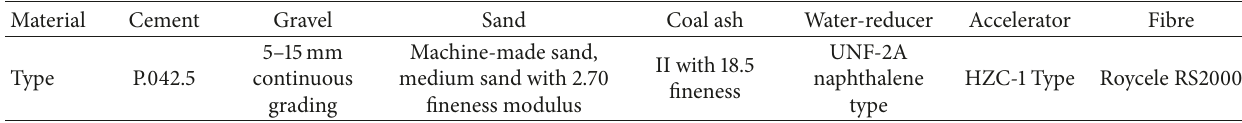
Figure 3: The concrete curing room for different temperatures. Table 2: Raw materials for the concrete used in this study.